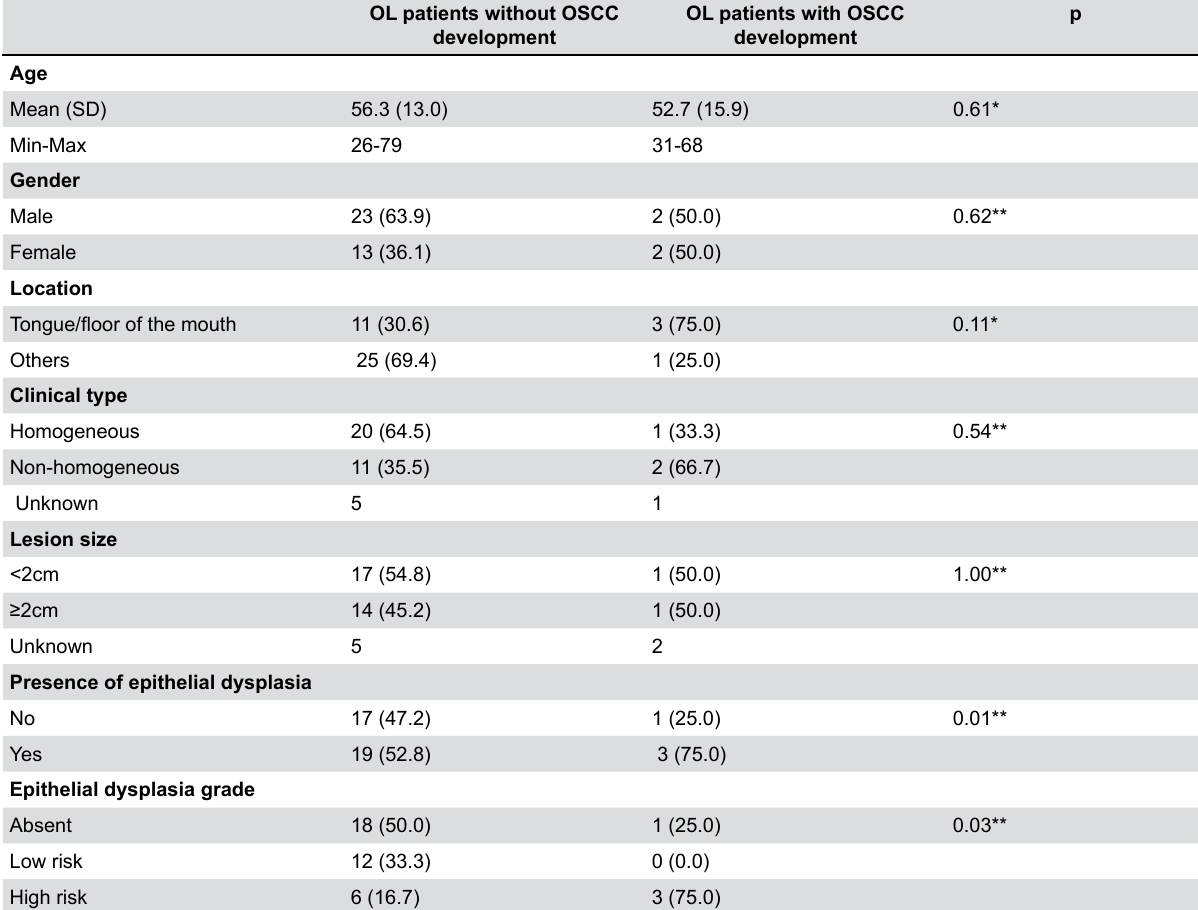
Table 2- Demographic and clinical characteristics of the OL with and without OSCC